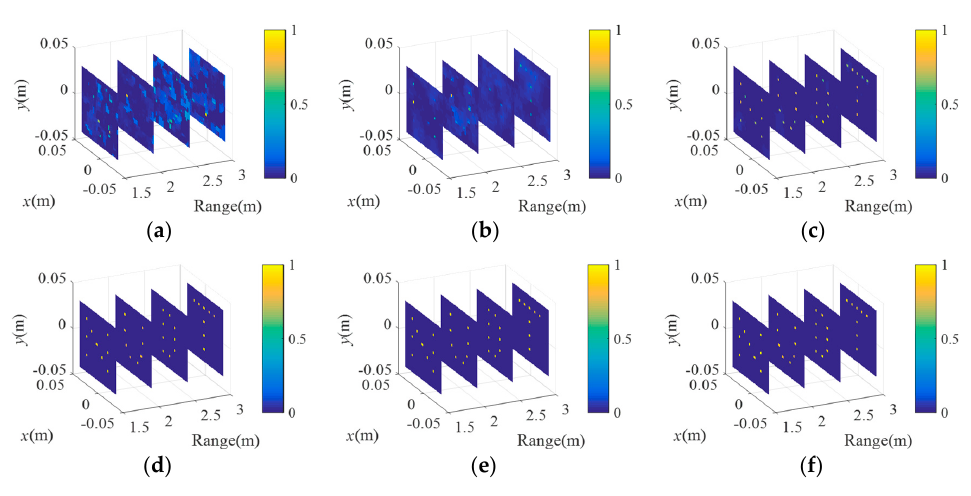
− 25 dB, − 15 dB, and − 5 dB.